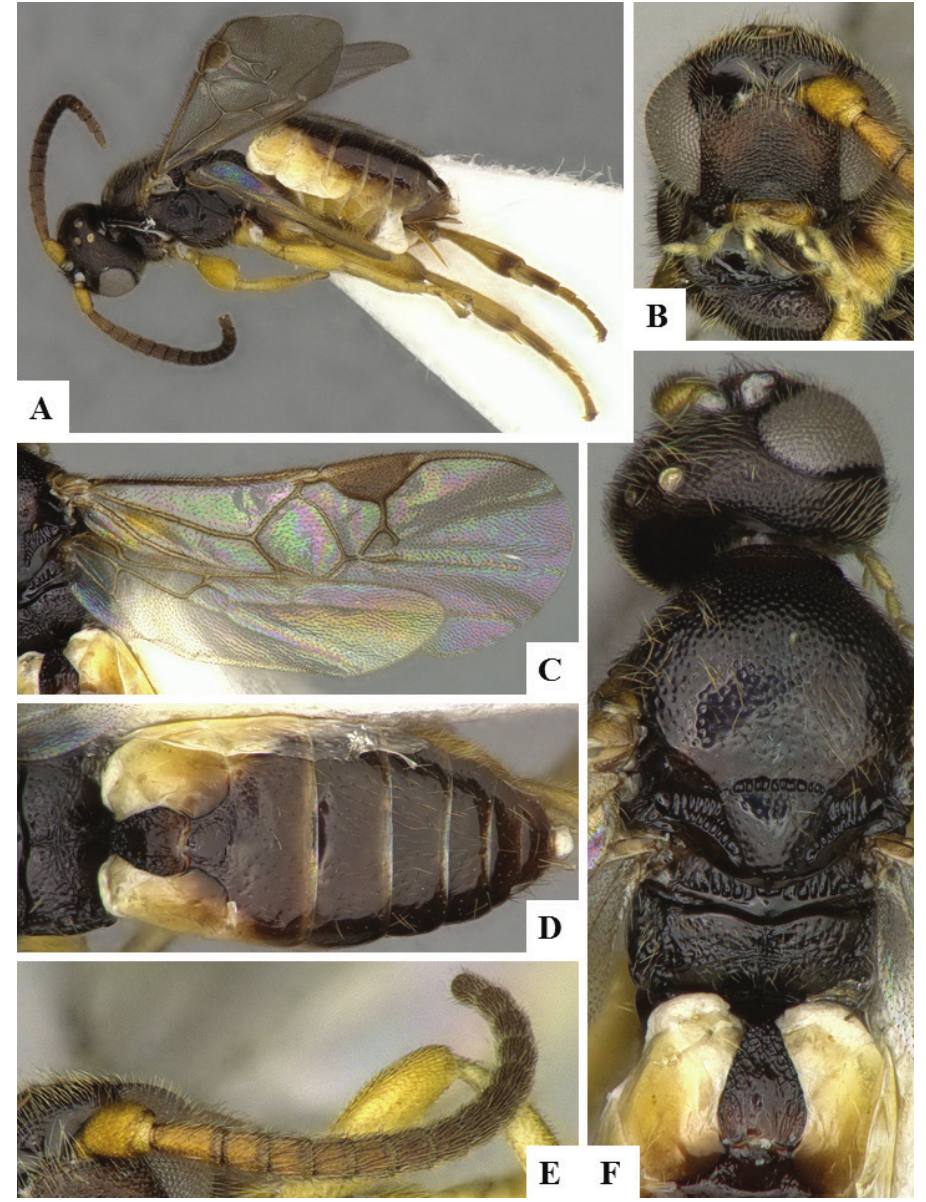
Figure 28. Markshawius erucidoctus female holotype. A Habitus B Head frontal C Fore wing and hind wing D Metasoma dorsal E Antenna F Mesosoma dorsal. lateral view of the head. Antenna very short (shorter than the combined length of head and mesosoma), with all flagellomeres but first with a single row of placodes. Prono- tum only with lower sulcus. Propodeum with median longitudinal carina clearly